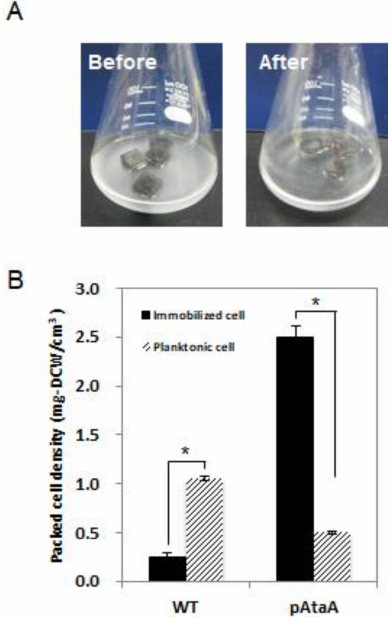
Figure 3. Immobilization of ataA -expressing E. aerogenes on polyurethane foams. A cell suspension of the transformant was shaken with polyurethane foams in the flask. ( A ) A clear suspension was observed after 2 h of shaking. ( B ) Immobilized cells were detached from the 4 pieces of polyurethane foams, and the cells were freeze-dried for dry cell weight (DCW) measurements. The DCW of the remaining cells in the 20 mL of suspension was also measured. Dry cell densities packed in the unit volume were calculated. Data are the mean ± SD of three independent studies. Significant differences between the data (student t- test, p < 0.01) are marked with an asterisk